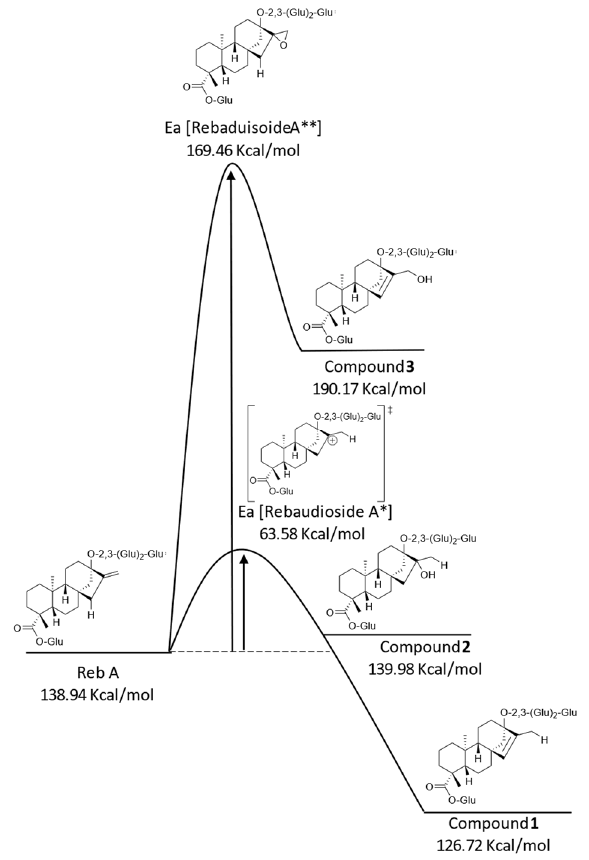
Figure 1. Mechanisms of rebaudioside A degradation.